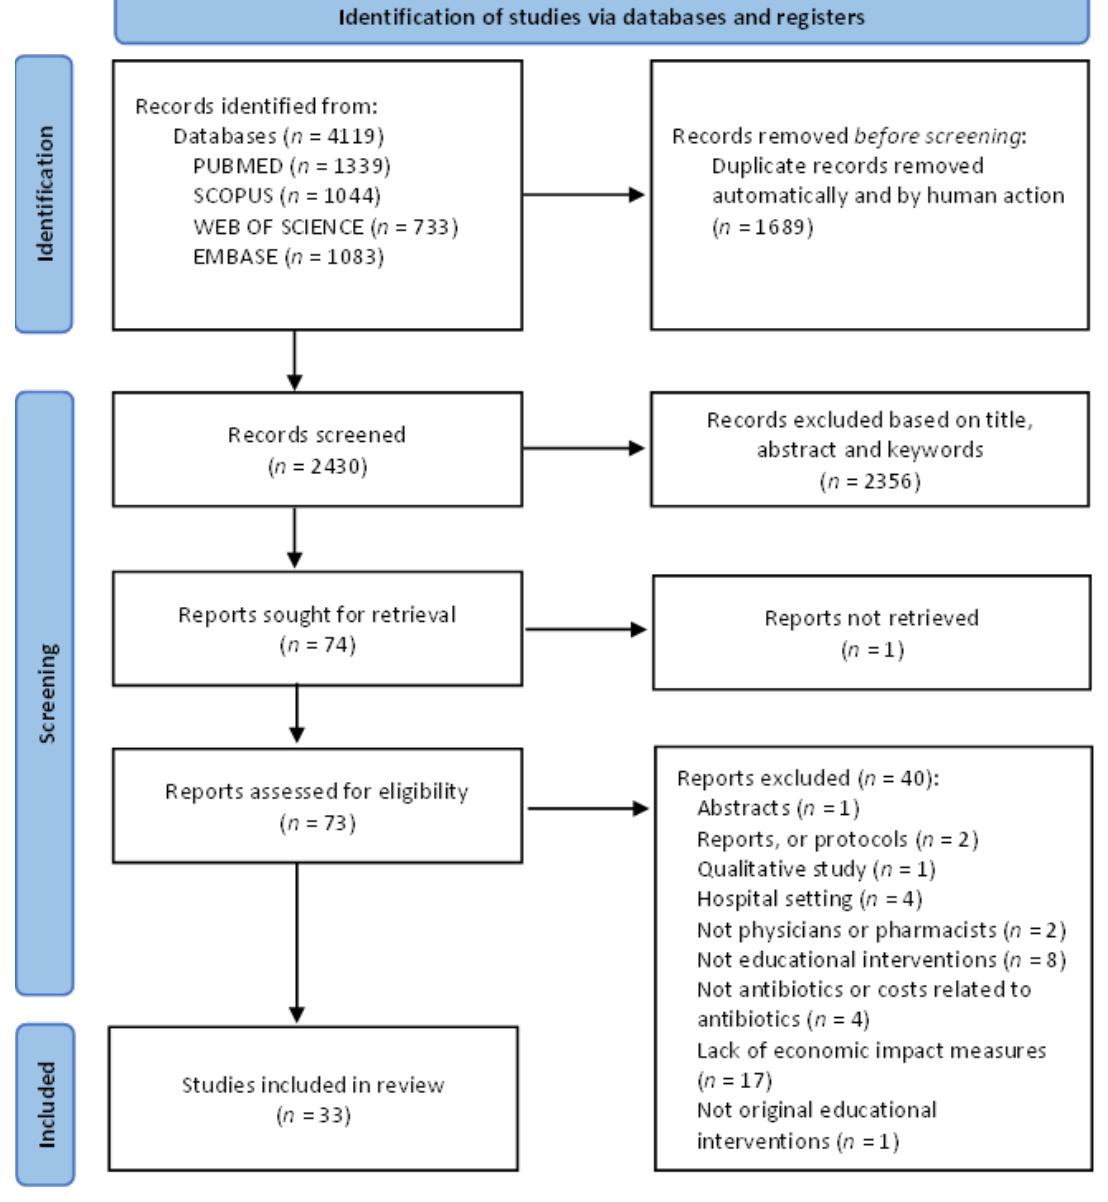
Figure 1. Decision Preferred Reporting Items for Systematic Review and Meta-analysis (PRISMA) flow diagram of the literature search (adapted from Page et al., 2021 [33]).